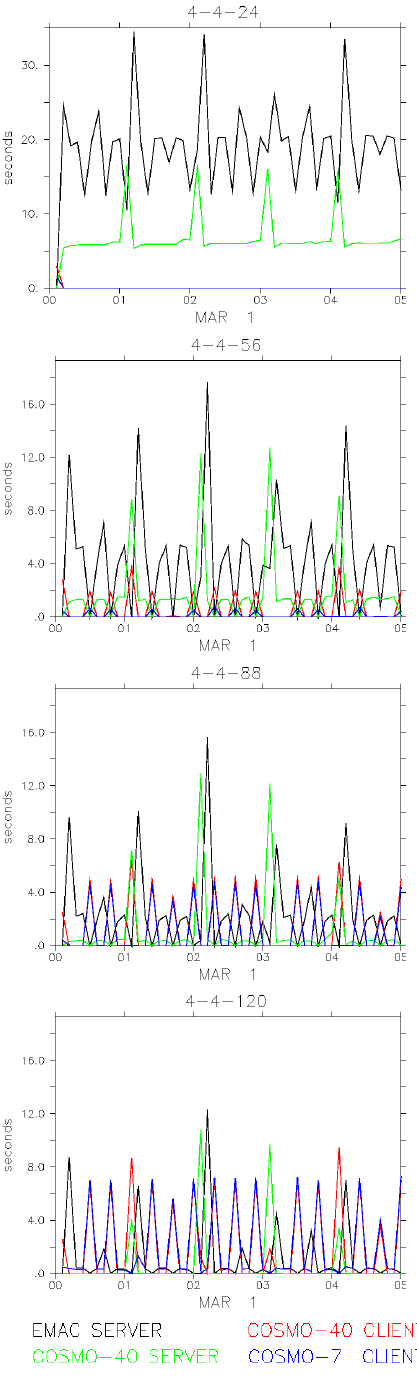
Fig. 6. Waiting times of the server and clients required for the four task distributions 4-4-24, 4-4-56, 4-4-88 and 4-4-120. The black and the green lines denote the time the ECHAM/MESSy and the COSMO/MESSy server tasks wait, respectively. The red and the blue lines indicate the waiting times of the COSMO-40/MESSy and the COSMO-7/MESSy clients, respectively.